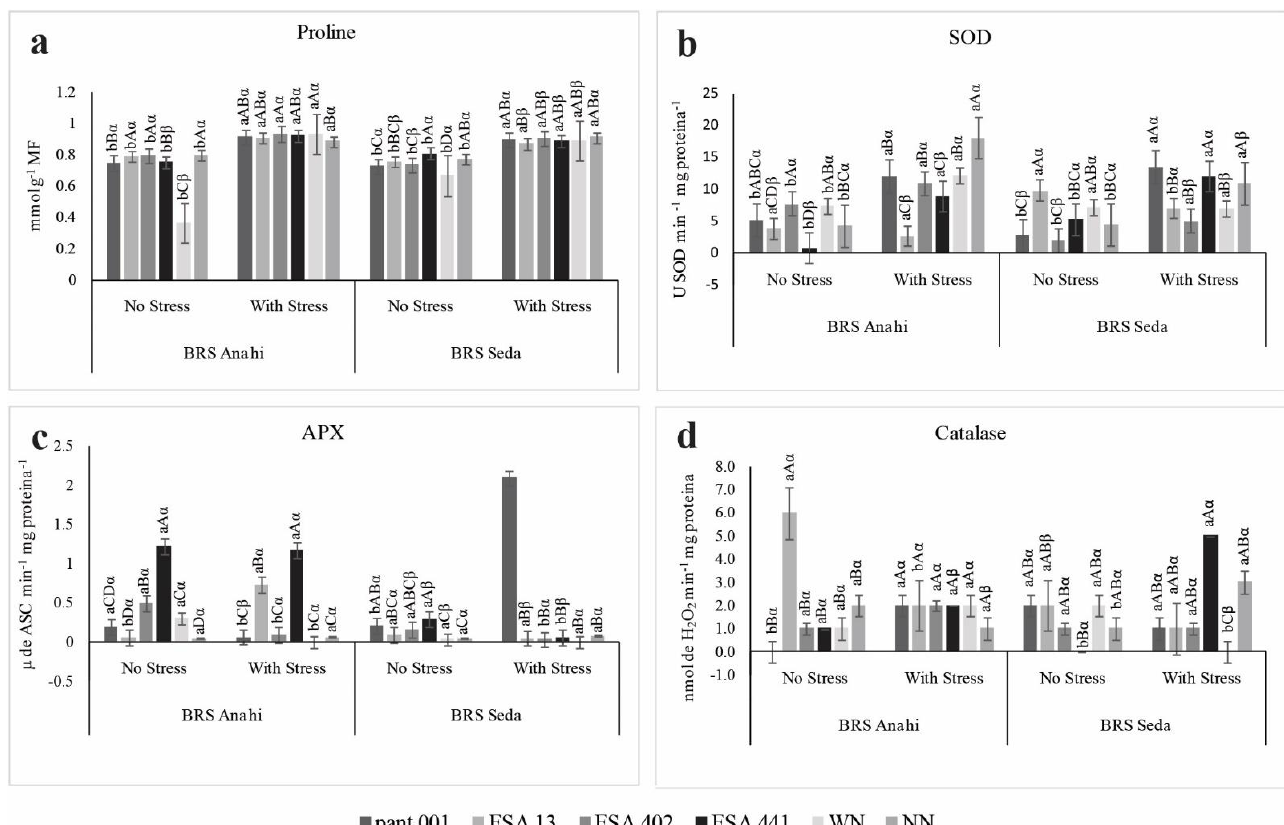
Figure 8. Concentration of proline ( a ), superoxide dismutase (SOD) ( b ), ascorbate peroxidase (APX) ( c ) and catalase (CAT) ( d ) as a function of water deficit in two sesame cultivars (BRS Seda and BRS Anahí) inoculated with bacilli. WN-with nitrogen and NN-no nitrogen.